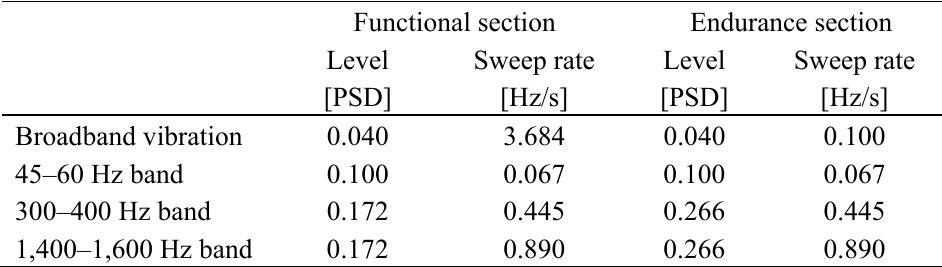
Table 2. Characteristics of vibration spectrum excitations for functional and endurance sections.